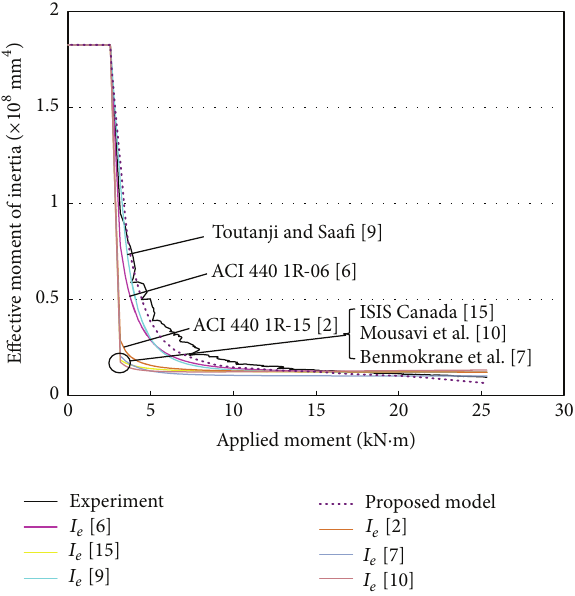
Figure 9: Moment-midspan deflection of FB-3.